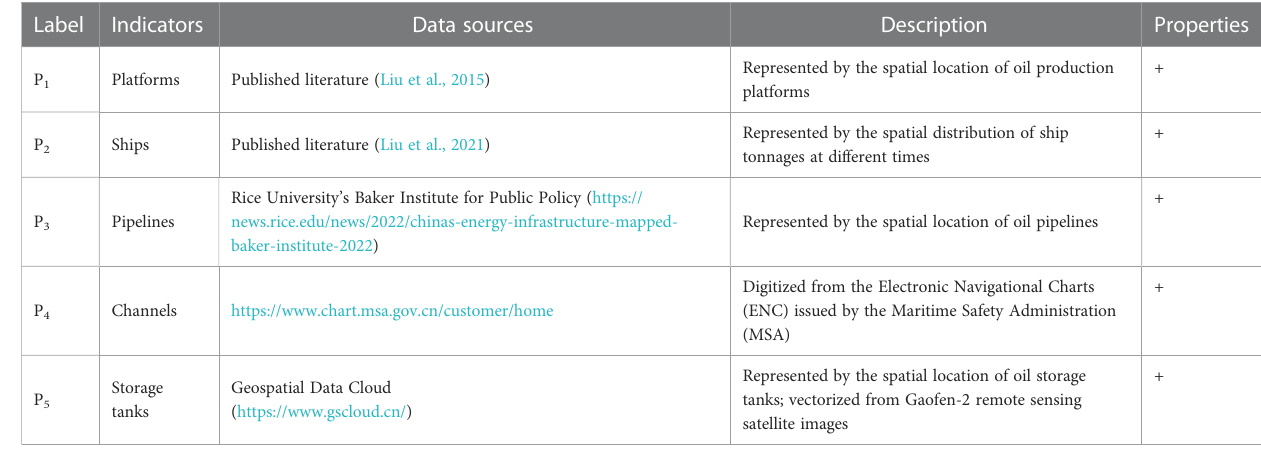
TABLE 1 Pressure indicators (after Wang et al., 2023).